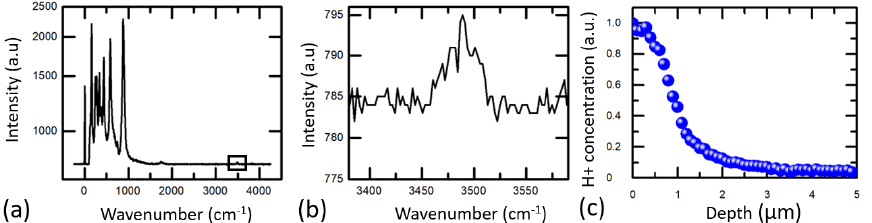
Figure 1. ( a ) Raman spectrum of SPE CLN. ( b ) Spectral region with the 3492 cm −1 line. ( c ) Depth dependence of the amplitude of the 3492 cm −1 line (relative concentration of H + ions) near the Z+ polar surface.